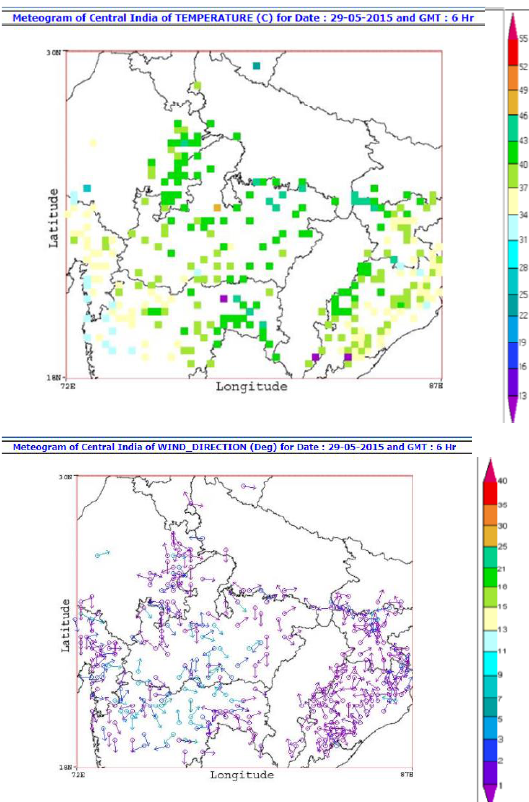
Figure 11: Temperature and Wind direction, May, 2015